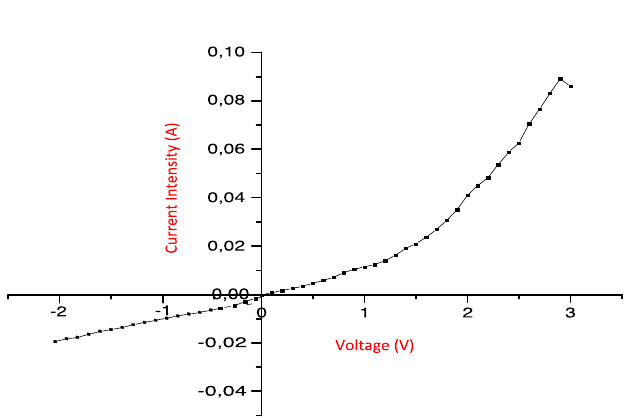
Fig. 1. I – V characteristic of the germanium junctions.